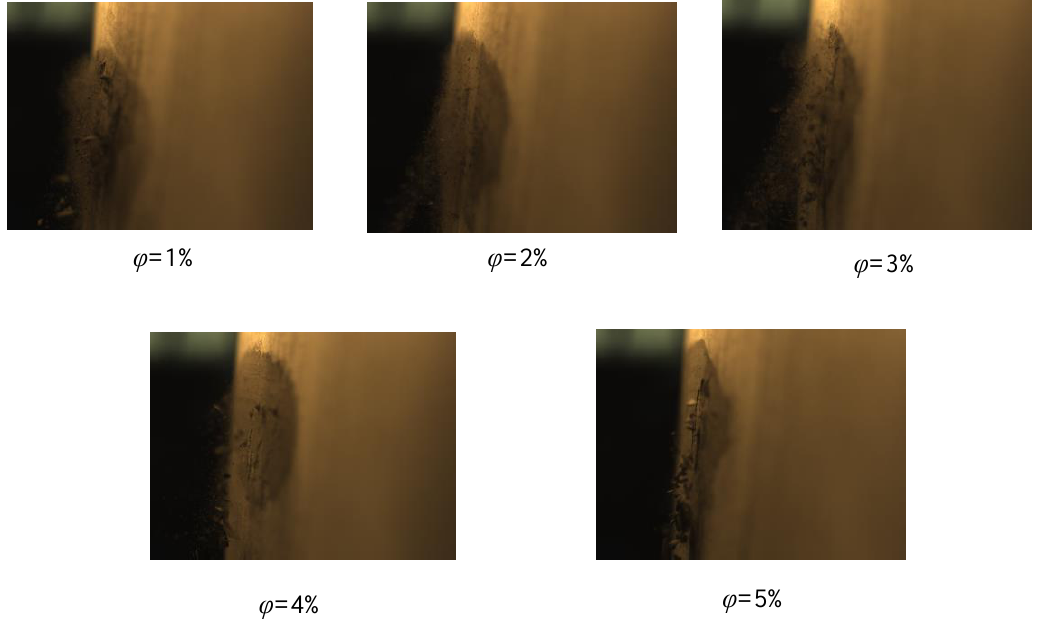
Figure 11. Dust peeling state under different dust moisture